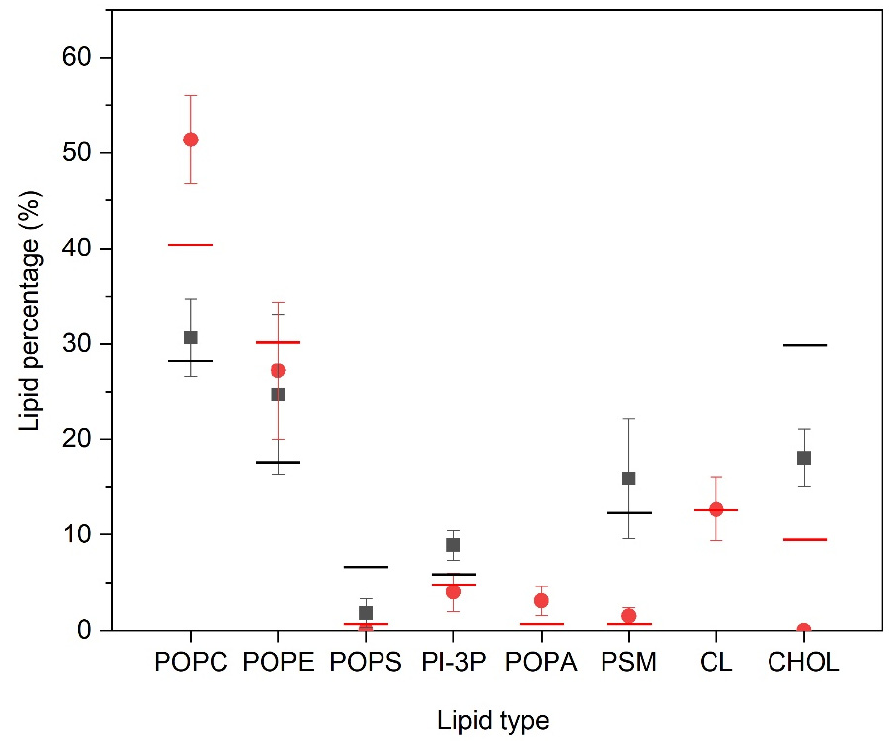
Figure 4. Relative percentage of the lipid molecules surrounding the PC1 molecules for the PM- containing systems ( ) and the MIT-containing systems ( ) for the last 30 ns of the MD simulation. Lines correspond to the global percentage of each one of the lipids in the system (— for PM- and— for MIT-containing systems).